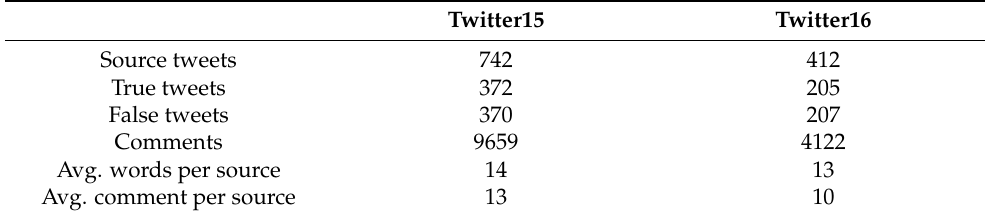
Table 1. Statistics of the the twitter15 and twitter16